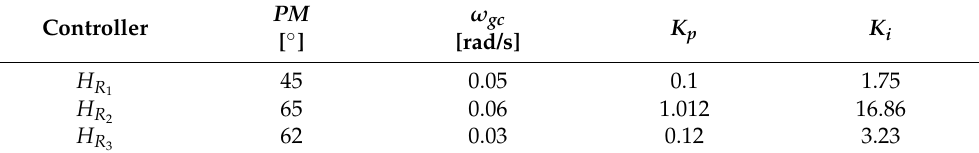
Table 1. The imposed performances and the resulting integer-order PI controller parameters. Controller